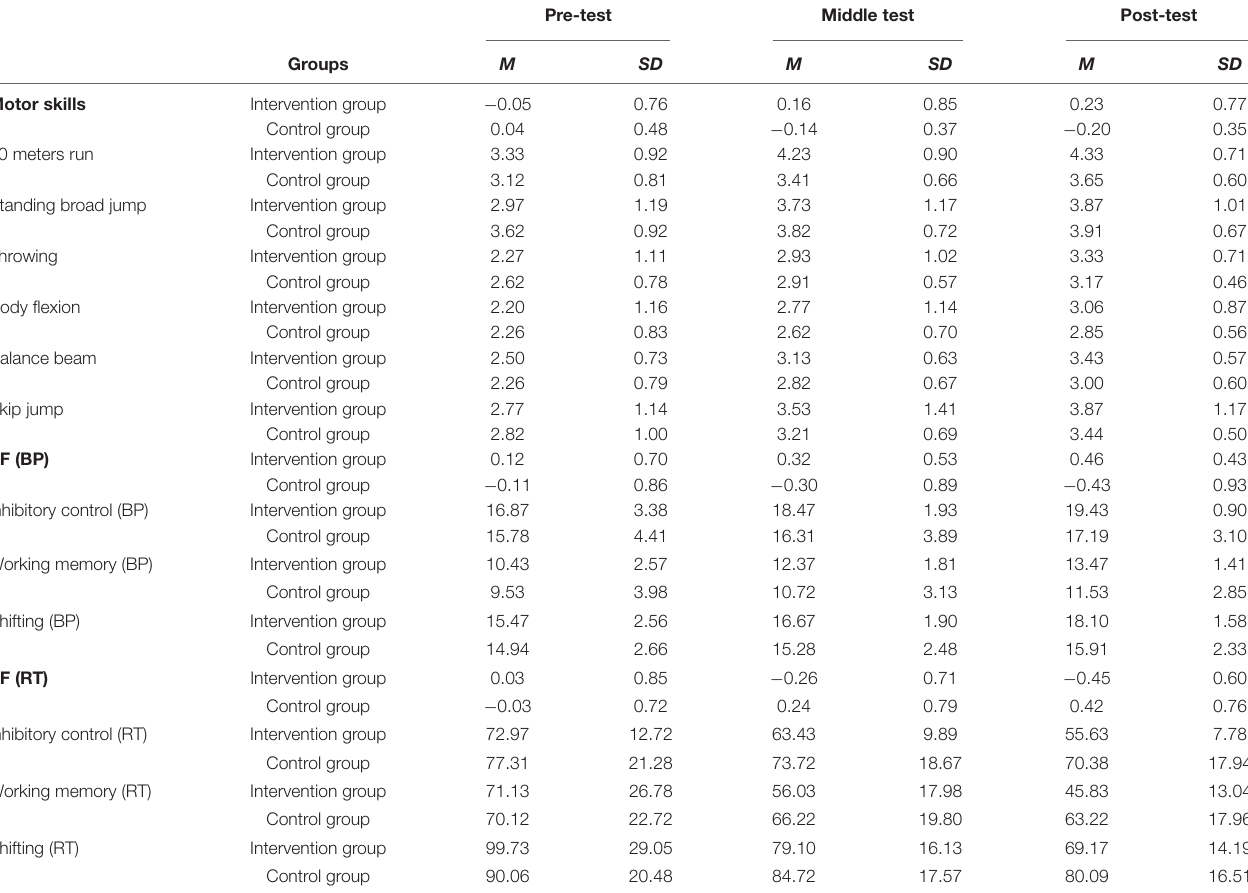
TABLE 1 | Descriptive analysis of motor skills and the behavioral performance and reaction time of EF tasks.